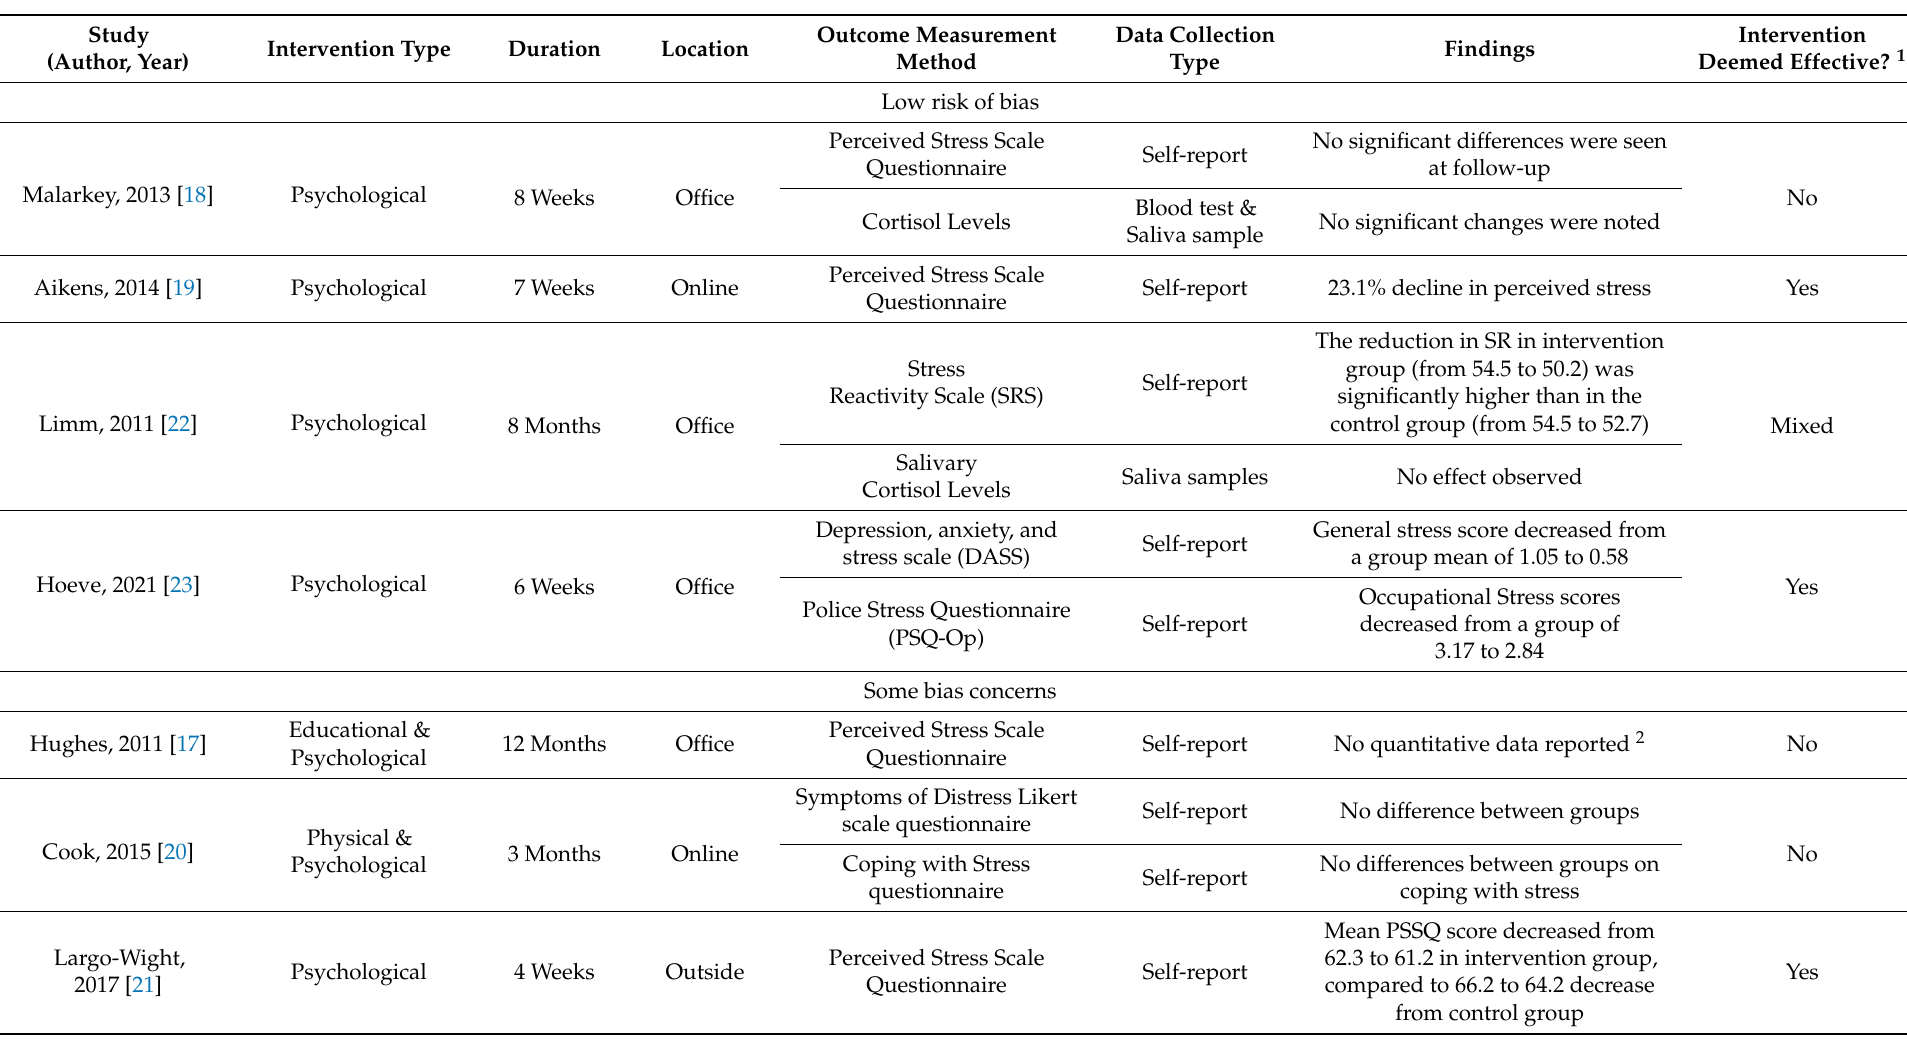
Table 6. Description of Methods and